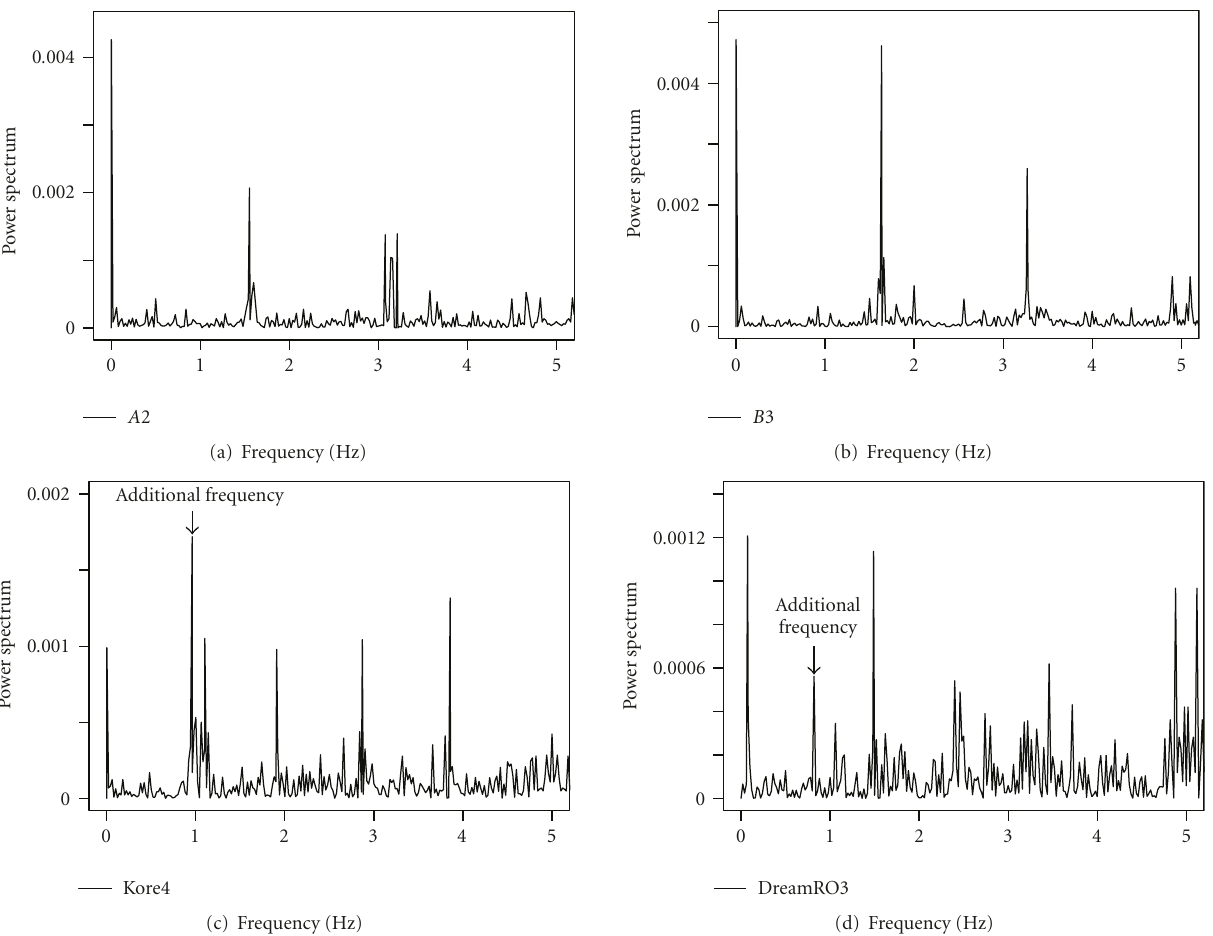
Figure 5: Power spectral density of packet arrival processes. Frequencies embedded in player traces are alike; however, bot traces display additional frequency components that do not appear in player